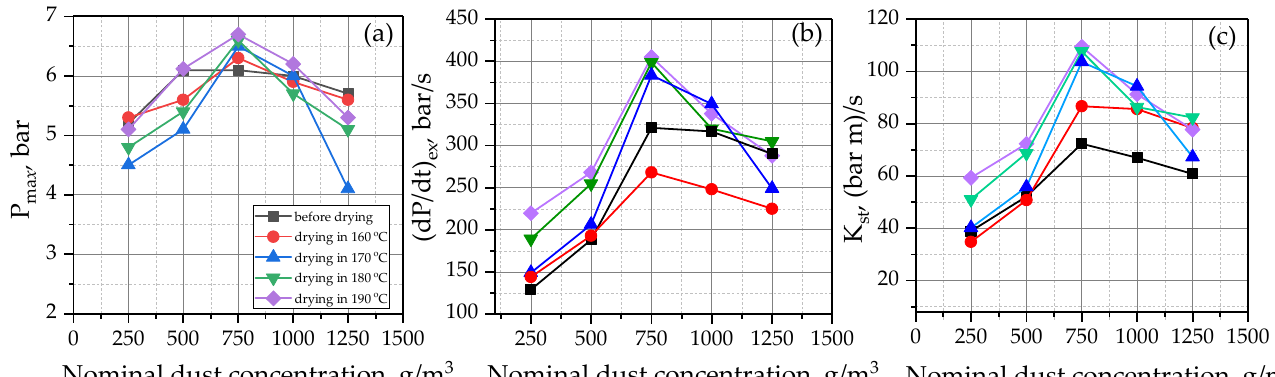
Figure 15. Impact of tobacco dust concentration on values of ( a ) P max , ( b ) dP/dt ex , and ( c ) K st.